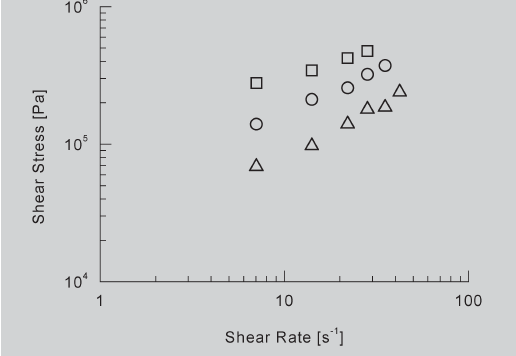
Figure 4 (left above): Flow curves of a maize starch containing 25% water at 100 ( (cid:2) ), 107 ( D ), and 115 °C (O). Results obtained in the mixer after calibration. Figure 5 (right above): Master flow curves of the maize starch after time temperature superposition at 107 °C. The water con- tents are 25 ( (cid:2) ), 27.5 ( D ), and 30 % (O). Figure 6 (right below): Flow curve of the maize starch at 107 °C and 30% water content: capillary rheometer ( (cid:2) ), Internal mixer (O). Both set of data were obtained after time- moisture-temperature